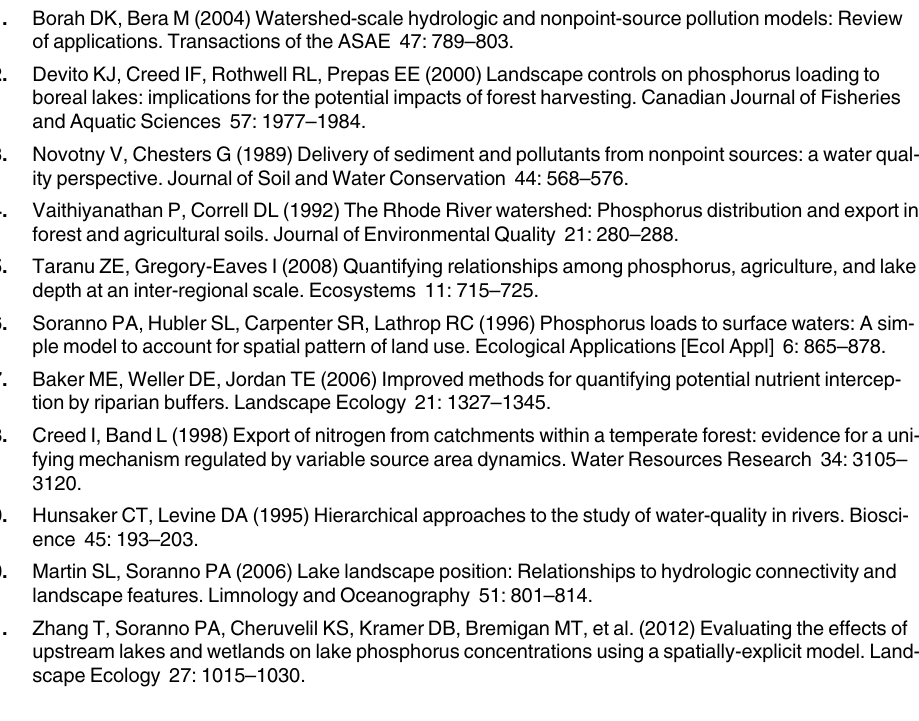
S1 Table. Correlation matrix of agricultural land use measured at the different spatial extents by lake